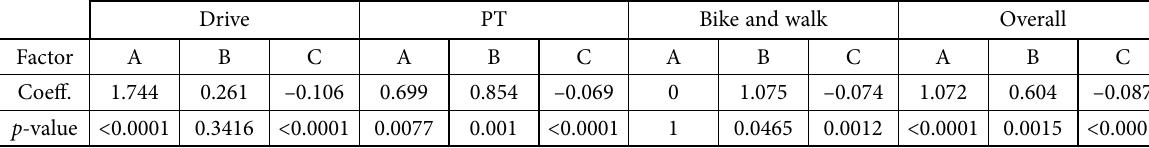
Table 6. Coefficients and p-values associated congestion-pricing support Drive PT Bike and walk Overall